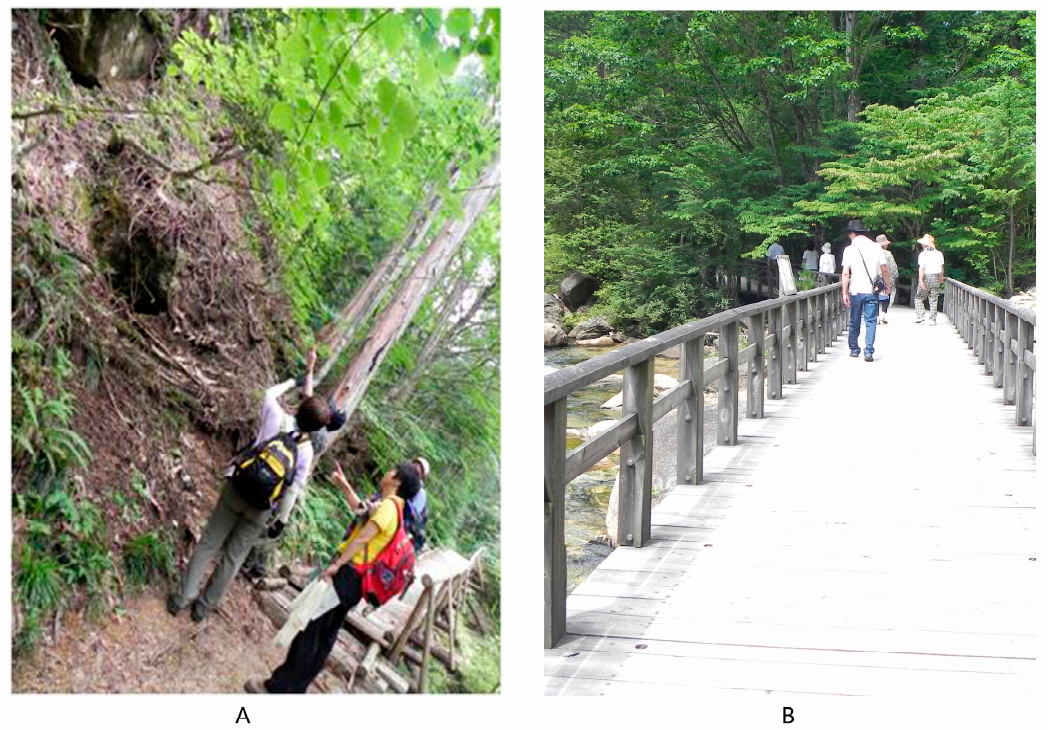
Figure 8. Di ff erent types of walking tourists. ( A ) Long residence time and long walking distance; Figure 8. Different types of walking tourists. A: Long residence time and long walking distance; B: ( B ) Short residence time and short walking Short residence time and short walking distance.